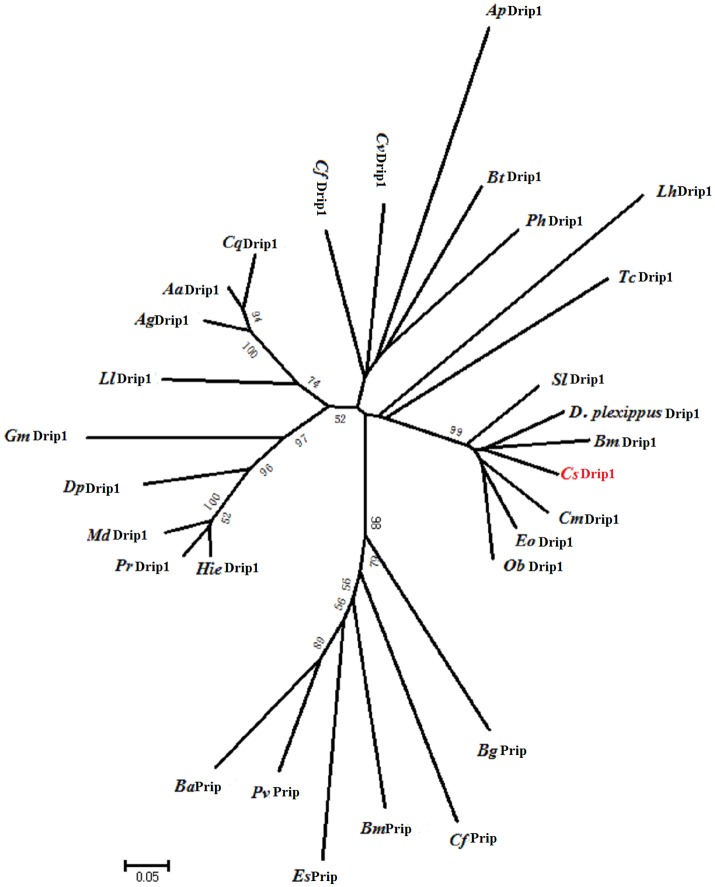
Neighbour-joining phylogenetic tree showing the Chilo suppressalis Drip1 (JQ011314 and JQ011315) with respect to other insect AQPs. BmDrip1 (Bombyx mori, AB178640), CmDrip1 (Cydia molesta, AB469882), AaDrip1 (Aedes aegypti, AF218314), PhDrip1 (Pediculus humanus, DS235154), TcDrip1 (Tribolium castaneum, CM000285), LlDrip1 (Lutzomyia longipalpis, EU124628), AgDrip1 (Anopheles gambiae, AAAB01008984), Cf Drip1 (Coptotermes formosanus, AB433197), HieDrip1 (Haematobia irritans exigua, U51638), CvDrip1 (Cicadella viridis, X97159), DpDrip1 (Drosophila pseudoobscura, CM000071), BtDrip1 (Bemisia tabaci, EU127479), GmDrip1 (Glossina morsitans, EZ422826), CqDrip1 (Culex quinquefasciatus, DS232465), ApDrip1 (Acyrthosiphon pisum, EU925136), D. plexippusDrip1 (Danaus plexippus, EHJ75085), EoDrip1 (Ectropis oblique, AMO02270.1), SlDrip1 (Spodoptera litura, AGT50942.1), ObDrip1 (Operophtera brumata, KOB73271.1), PrDrip1 (Phormia regina, BAM26200.1), MdDrip1 (Musca domestica, AIB09141.1), LhDrip1 (Lygus hesperus, AHI85743.1), EsPrip (Eurosta solidaginis, FJ489680), BgPrip (Blattella germanica, FR744897), Cf Prip (Camponotus floridanus, GL435707), BaPrip (Belgica Antarctica, AB602341), PvPrip (Polypedilum vanderplanki, AB281619), and BmPrip (Bombyx mori, AB458833). Numbers on the branches are the bootstrap values obtained from 1,000 replicates (only bootstrap values >50 are shown).